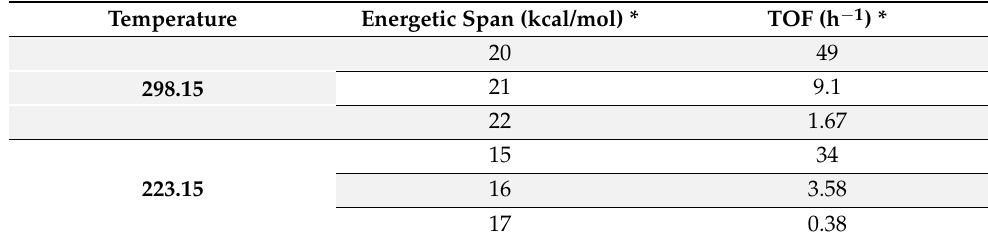
Table 2. Energetic span and TOF at 223.15 K and 298.15